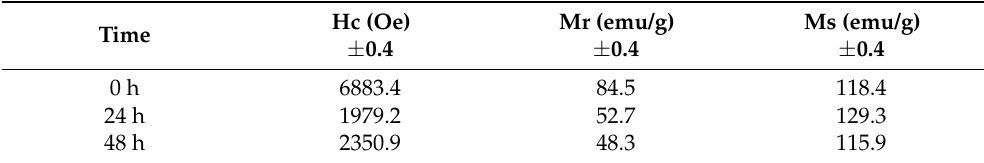
Table 7. XRD parameters of the sintered Nd 2 Fe 14 B/Fe 90 Al 10 system at 300, 400 and 500 °C, respec- tively.